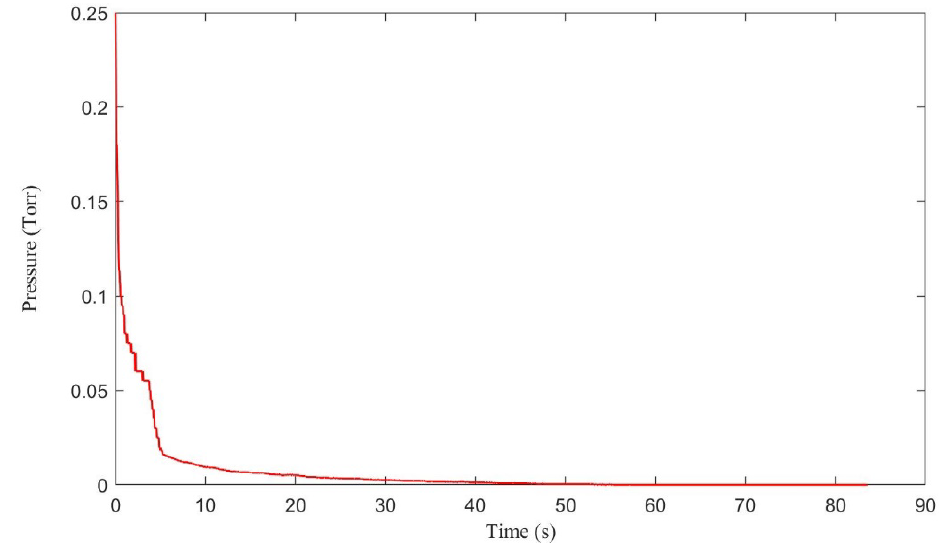
Figure 7. The sealing rate for a fully heat-treated, sealed, 98% overlap part printed nine at once. The pressure reached by each infill overlap percentage before and after heating was averaged over the last minute in [38]. A 95% confidence interval was used to produce the error bars in the results. The value contributing minute had to be corrected for some of the samples which had anomalies during the last minute of measurement; an example is shown in Figure 6. The value contributing minute was manually selected over a plateau